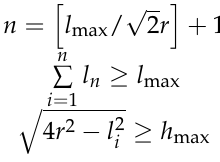
√ 2 r . The √ 2 r when the